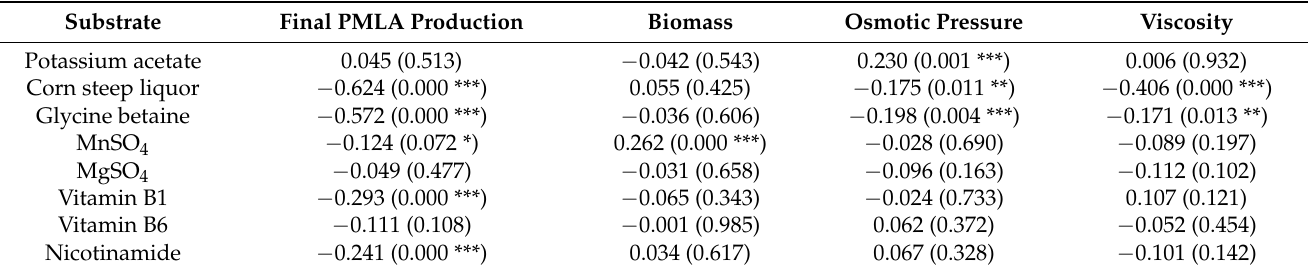
Table 2. The correlation matrix of different substrates with final PMLA production, biomass concen- tration, osmotic pressure, and